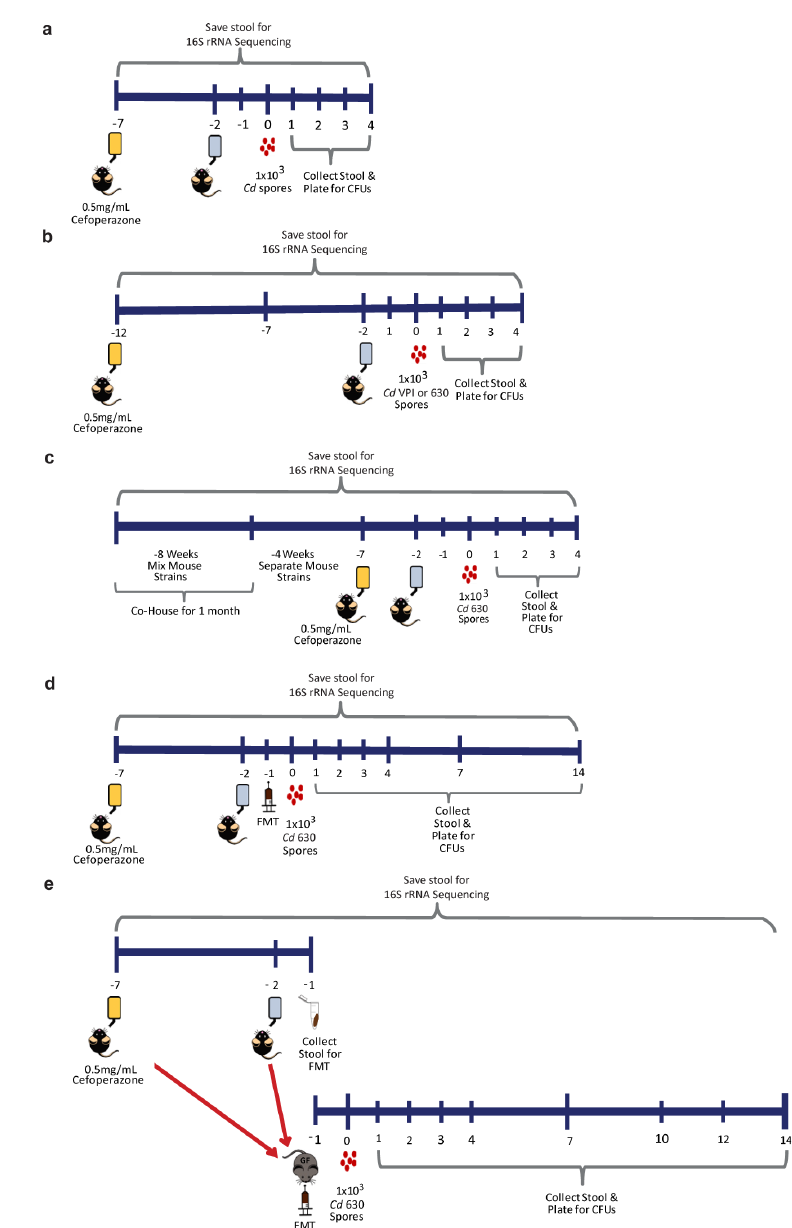
Fig 1. Experimental design for experiments performed in this study. (A) Standard model of CDI. Mice were given antibiotics in drinking water 5 days, normal water for two days rest, then inoculated with 1x10 3 Cd 630 spores. (B) Ten-day antibiotic treatment with inoculation of Cd 630 or Cd VPI strains. (C) Co-housing strategy. (D) FMT of conventional SPF WT and MR1 -/- mice. (E) FMT of SPF antibiotic treated or untreated donor stool into WT germ-free